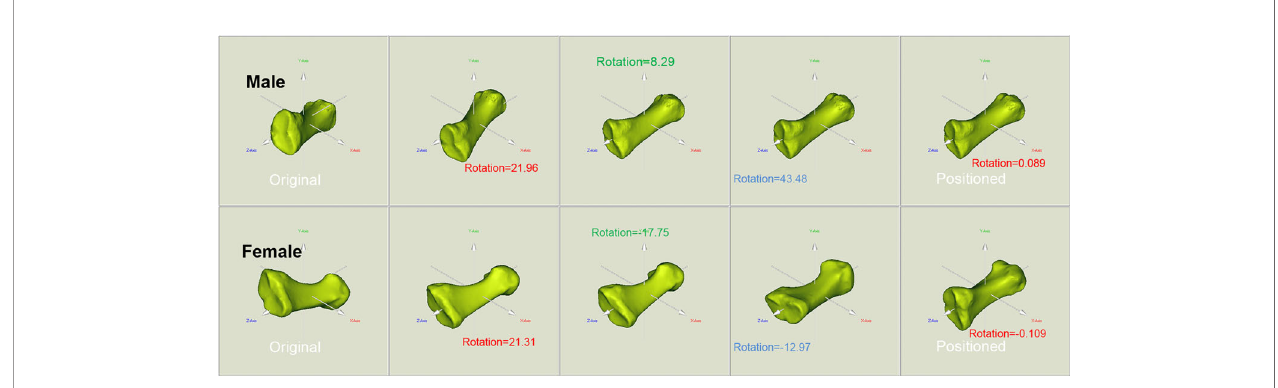
FIGURE 2 | Positioning of the reconstructed bone alongside the body coordinate system of the male and female metatarsals. To facilitate the location and orientation positioning, COMs were aligned and the PAIs were used to de fi ne the coordinate system within each metatarsal. The rotation around the x , y , and z axes allows to achieve the alignment of the